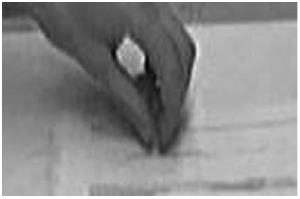
FIG. 2 (color online). Gestures in episode